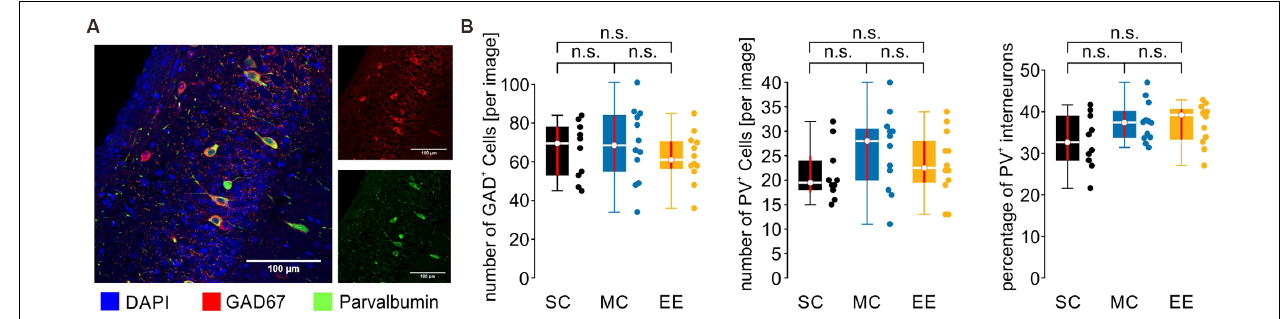
FIGURE 5 | The number and distribution of inhibitory and PV + inhibitory cells are not different between control animals and environmental enrichment. (A) Example image from CA1. Cell nuclei are stained by DAPI in blue, inhibitory cells by GAD67 in red, and PV + inhibitory cells in green. (B) Neither the number nor the percentage of inhibitory and PV + inhibitory cells is changed by environmental enrichment. N = 10 slices from five mice for standard conditions, N = 12 slices from six mice for motor control, and N = 12 slices from six mice for environmental enrichment. Red lines depict the confidence intervals of the median assessed by bootstrapping. n.s., not